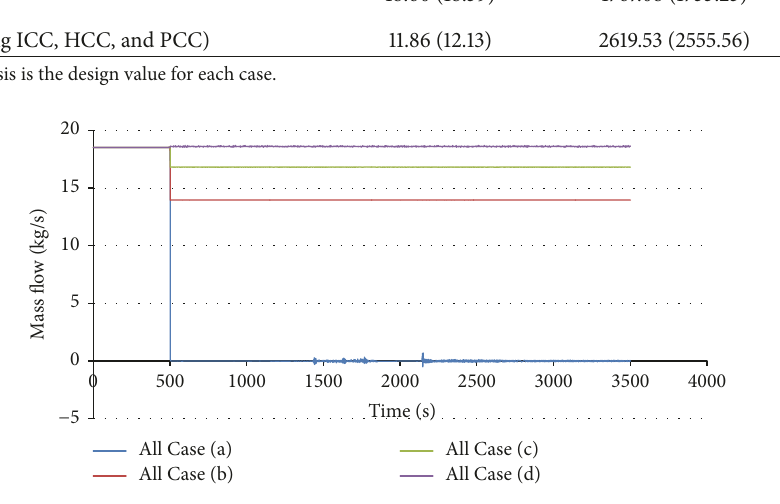
Figure 11: Mass flow rates resulting from the LOFAs.